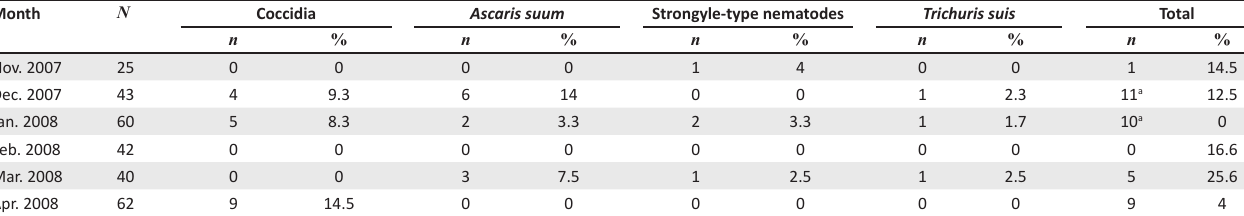
TABLE 4: Prevalence of gastrointestinal parasites in pigs according to time of